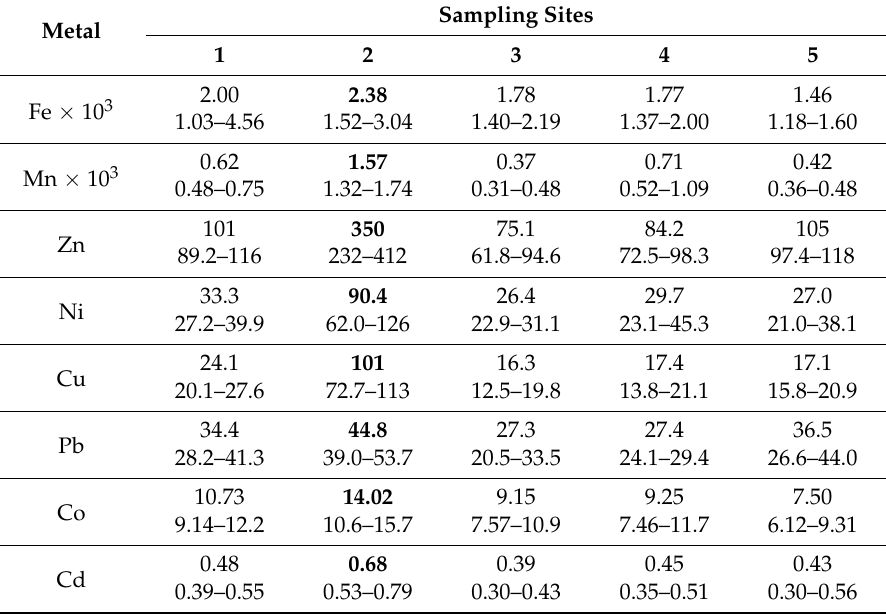
Table 2. Mean total metal concentrations (mg · kg − 1 ) in sediments of five sites in Lake Taihu a . Sampling Sites Metal 1 2 3 4 5 Fe × 10